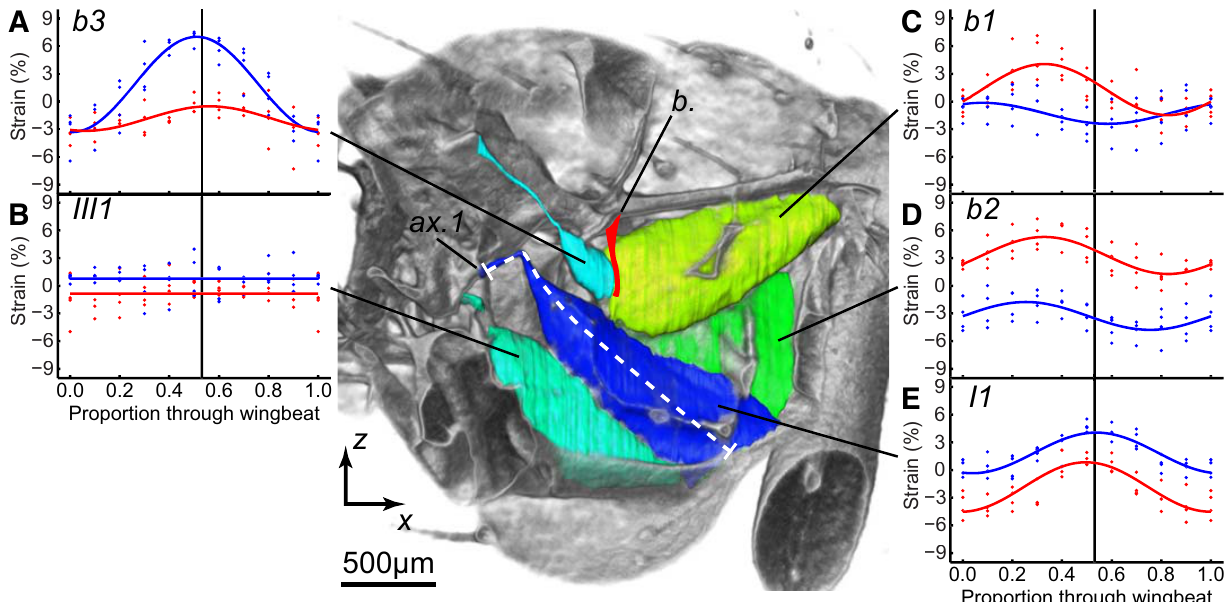
Figure 6. Cutaway visualization of the steering muscles and measured strains. Cutaway visualization of the steering muscles, looking out toward the wing hinge, with graphs of their measured strains (blue, high-amplitude wing; red, low-amplitude wing). The data points plot the strains measured for each individual fly ( n =4) at every stage of the wingbeat, starting at the beginning of the downstroke. The fitted curves are simple harmonic functions, except in the case of III1 , which showed no significant time-periodic strain. Black vertical lines indicate the mean timing of the start of the upstroke. The strain in I1 was measured along a line running down the middle of the muscle and its tendon (white dashed line) to take account of buckling. Movie S2 animates this view through the wingbeat for both wings. b ., basalare sclerite (filled red); ax.1 , first axillary sclerite. Movie S2 can be viewed here.